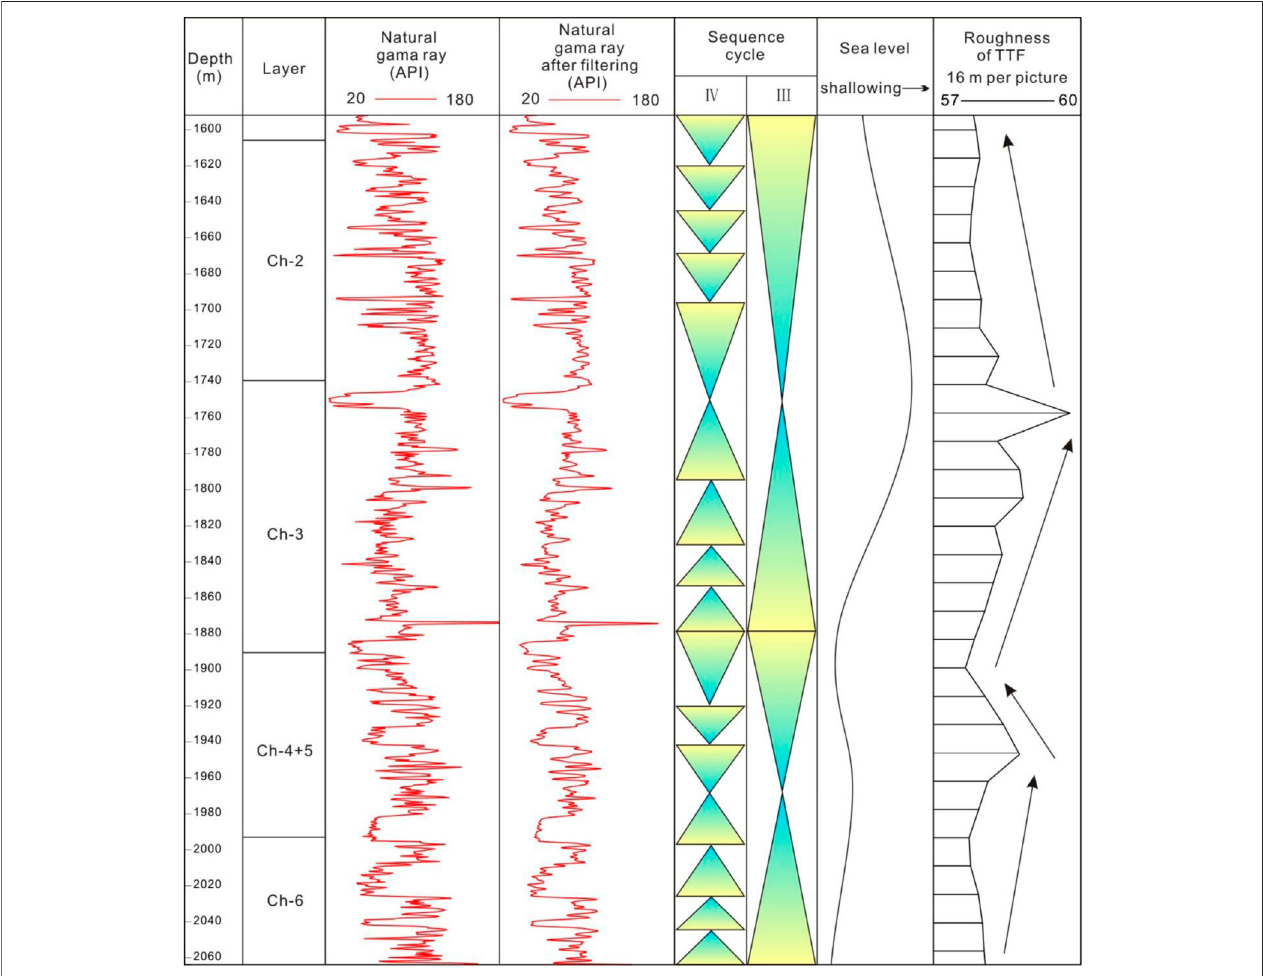
FIGURE 12 | Comparison of TTF analysis results and sedimentary cycles at different scales. When the thickness of the formation is 16 m, the change trend of the roughness of the imaging log perfectly matches the change of sea level.